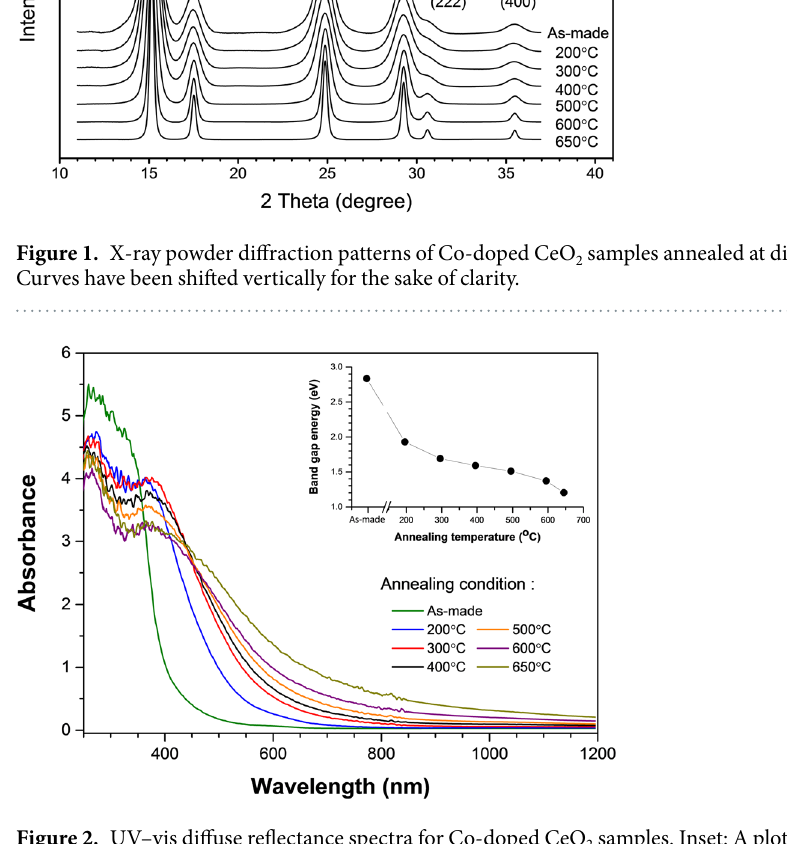
Figure 2. UV–vis diffuse reflectance spectra for Co-doped CeO 2 samples. Inset: A plot of band gap energy vs. annealing